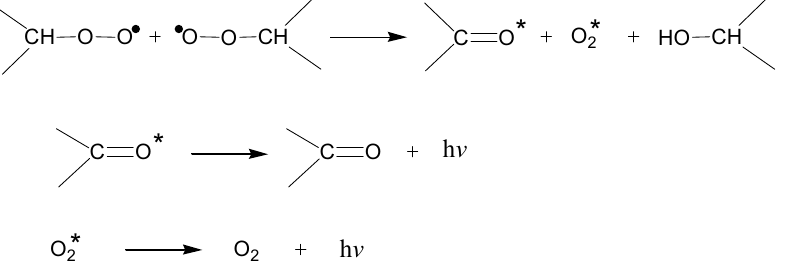
Scheme 2. Mechanism of the population of excited states from carbonyls and oxygen subsequently emitting light. Asterisks denote the excited states of ketones (triplet) and oxygen (singlet), which are converted to the ground state with the emission of